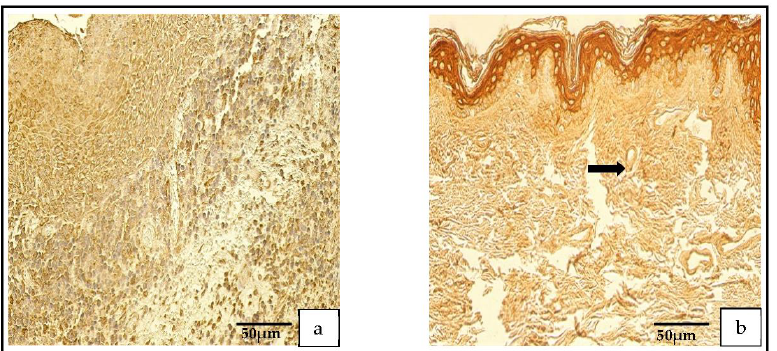
Figure 3. ( a , b ) Immunohistochemical micrographs. ( a ) Cholesteatoma. Numerous VEGF-positive cells in the matrix and moderate VEGF-positive endothelial cells in the perimatrix, VEGF IHC. ( b ) Skin. Numerous VEGF-positive cells in the epithelium and a few VEGF-positive endothelium cells of connective tissue (arrow), VEGF IHC.